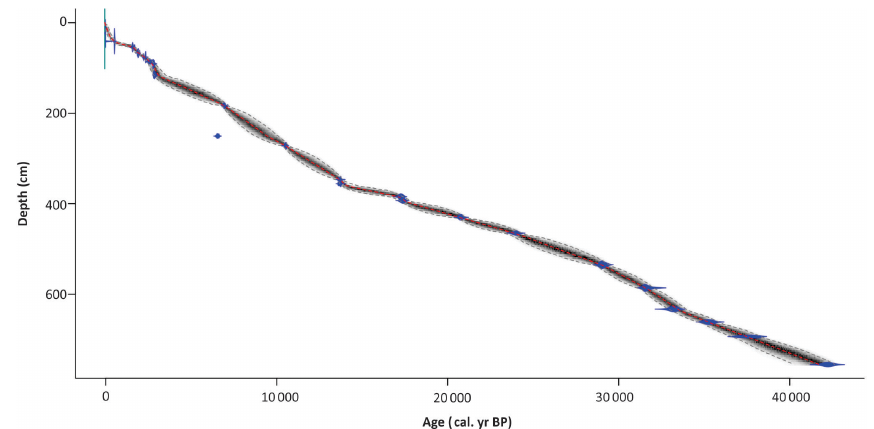
Figure 3. Depth–age model of Mfabeni core MF4-12 produced using Bacon, based on 24 14 C AMS dates (Sect. S1). Blue symbols are AMS dates and grey shading indicates the 95% confidence interval on the mean age (red